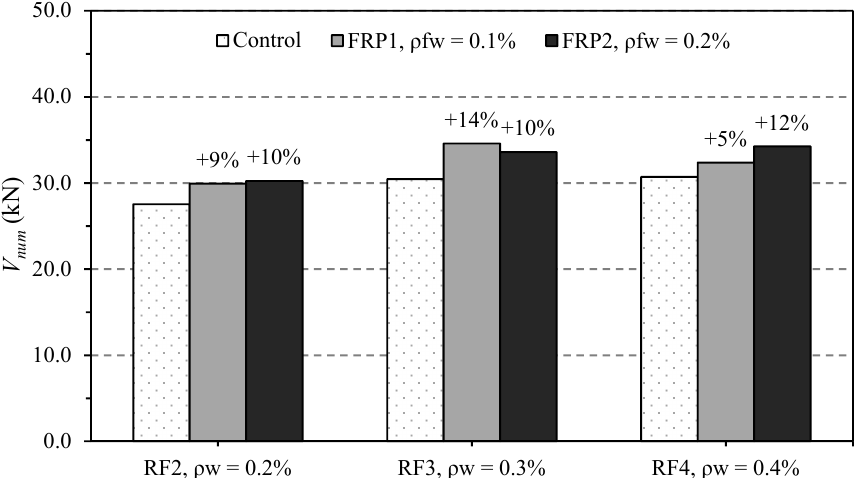
Figure 18. FE analysis on the effect of steel shear reinforcement on the shear strength of FRP- strengthened beams (difference to control specimen in %).